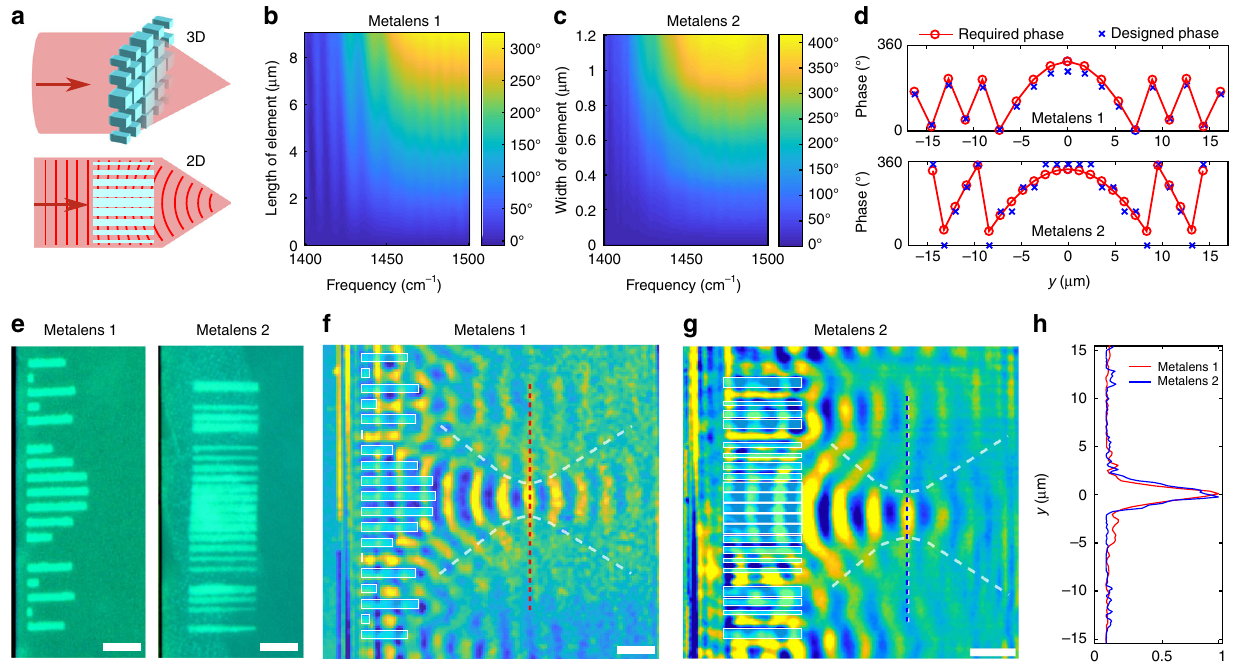
Fig. 4 Recon fi gurable metalenses. a Adaptation of metalenses to the 2D case. Each discrete element changes the local phase of light, so the wavefronts converge to a focal spot. b , c Local phase (in degrees) of each element as a function of the element parameter and the frequency. b refers to unit cells with period 1.8 µ m, 1 µ m width and variable lengths. c refers to unit cells with period 1.2 µ m, 9 µ m length and variable widths. d Designed phase pro fi le of the two metalenses (see Supplementary Note 2 for additional information). The design frequency was 1452 and 1448cm − 1 for metalens 1 and metalens 2, respectively. e Optical images of the written metalenses. Metalens 1 was written, characterised, erased and subsequently the same area was recon fi gured into metalens 2. f s-SNOM image of metalens 1 showing focusing of polaritons at 1452cm − 1 . g s-SNOM image of metalens 2 at 1445cm − 1 . h Intensity pro fi le (square of s- SNOM signal) at the cross-section of the diffraction-limited focused polariton beam for both lenses (dashed vertical lines in f , g ). Scale bars are 5 µ